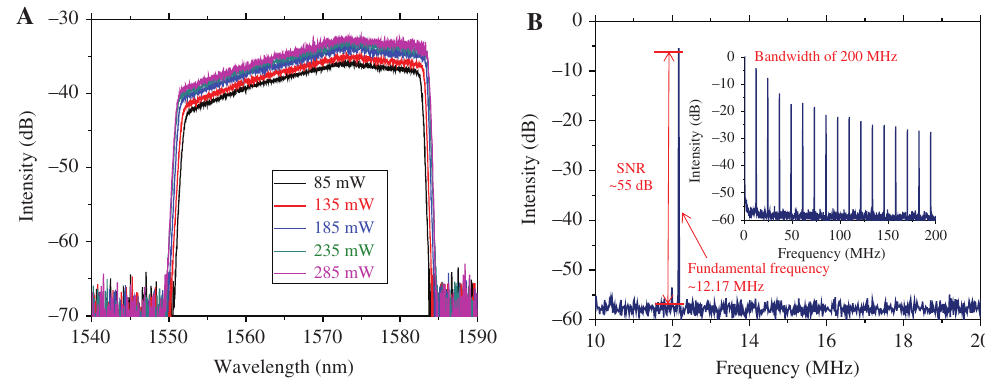
Figure 9: Spectral evolution and stability characteristics of the DS operation (A) Emission optical spectra under different pump powers. (B) RF spectrum of the mode-locked DS operation. (Inset of B) RF spectrum recorded within 200 MHz